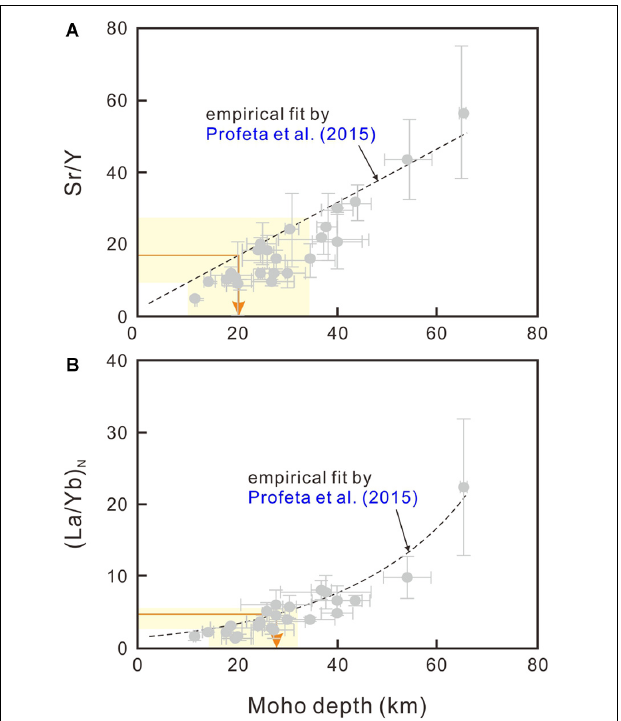
FIGURE 11 | Estimation of crustal thickness using Moho depth proxies (A) Sr/Y and (B) (La/Yb) N where subscript N denotes normalization against CI chondrite (Sun and McDonough, 1989). Dotted line denotes empirical fits of data for a given volcanic arc shown by gray symbols (Profeta et al., 2015). The yellow band and orange line denote the range and median, respectively, of data for the intermediate suite, which generally satisfy the filters proposed by Profeta et al. (2015) including ranges of SiO 2 (55–68 wt.%) and MgO (1–6 wt.%). If data for monzogranites are included, the median for Sr/Y remains unchanged ( ∼ 17) while that for (La/Yb) N is slightly higher ( ∼ 6.9).